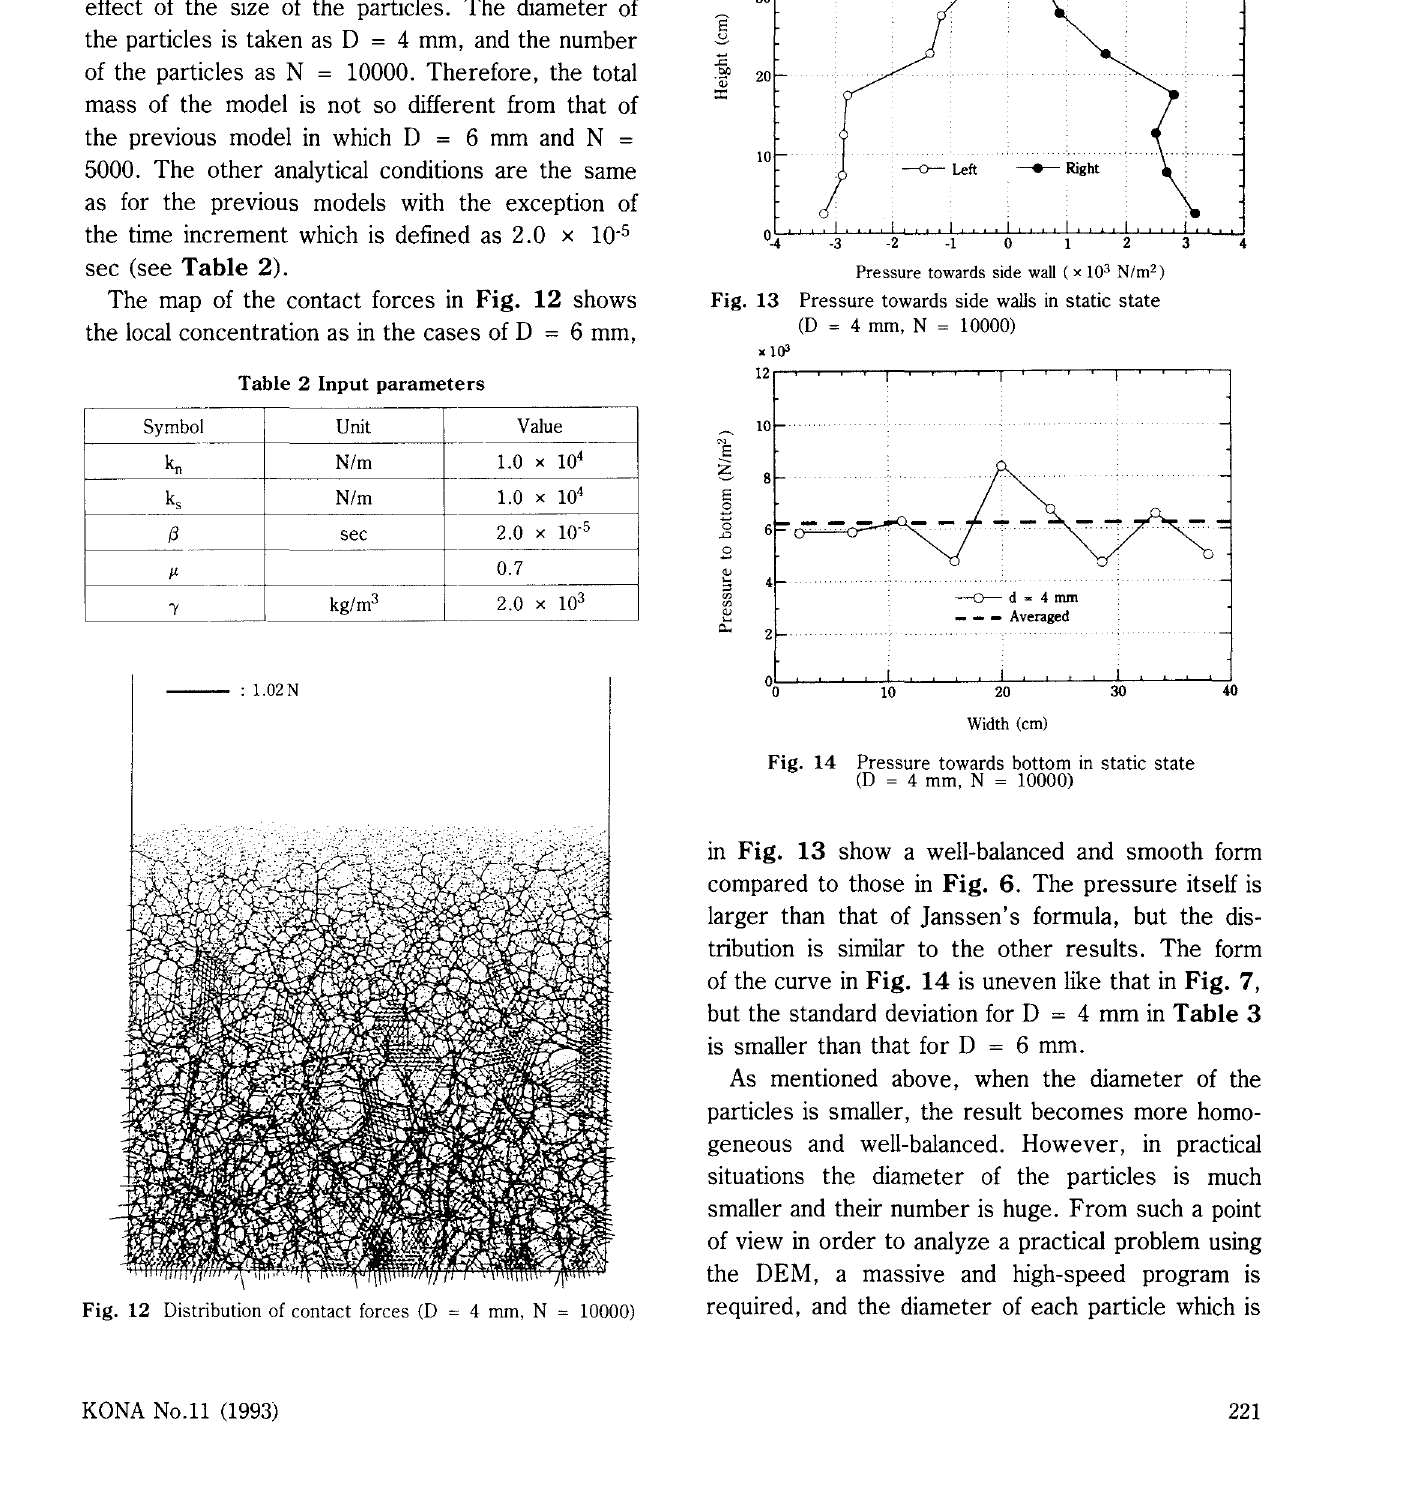
KONA No.ll (1993)